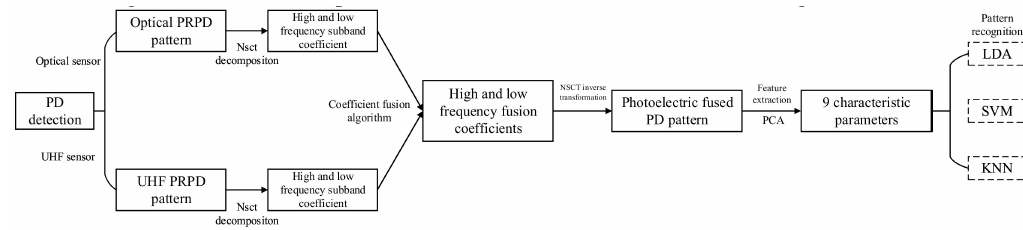
Figure 11. Experiment verification of the overall